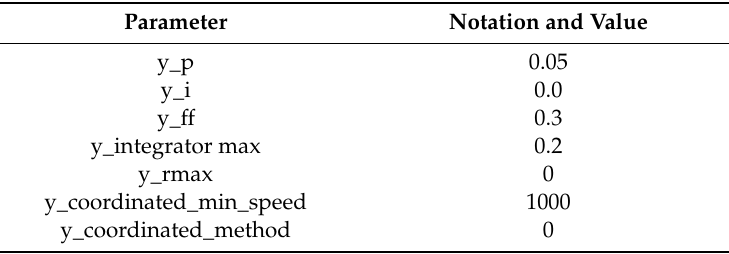
Table A3. Yaw angle control system